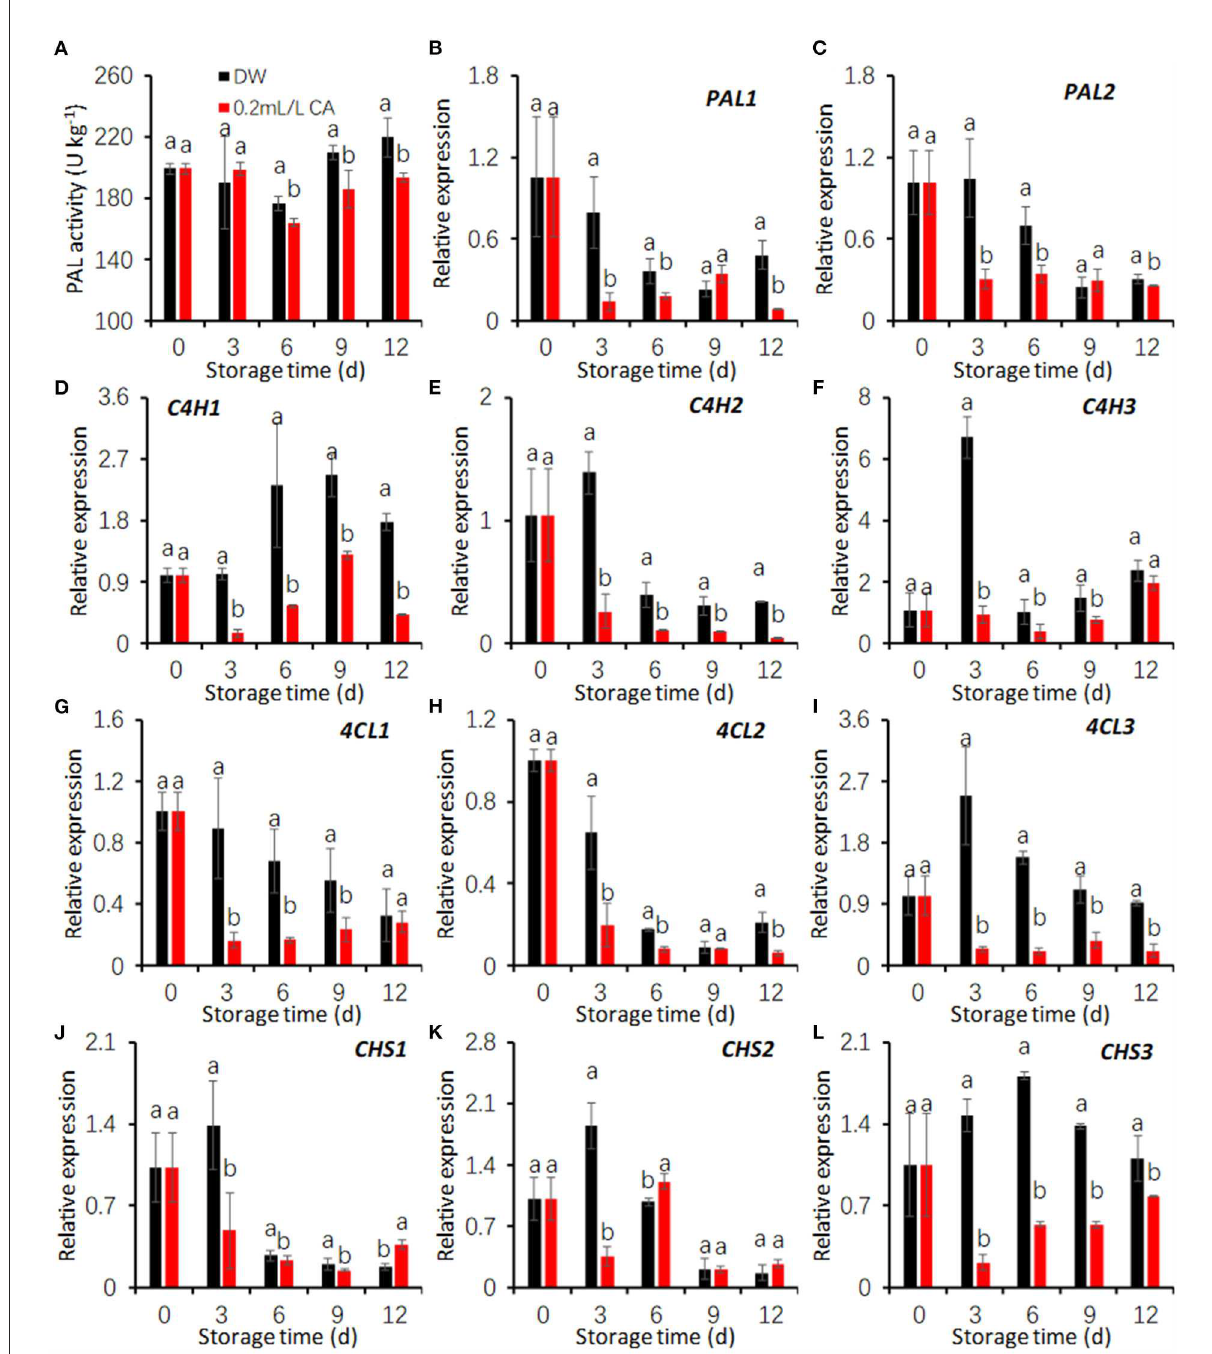
FIGURE4 Effects of 0.2 mL/L citronellal (CA) treatment on the phenolic biosynthesis in fresh-cut taros. (A–C) PAL activity and gene expression; (D–F) relative expression of C4H genes; (G–I) relative expression of 4CL genes; (J–L) relative expression of CHI genes. DW, distilled water. The expression levels were all normalized to 100% (1.0) at 0 d (before treatment). Each value is presented as the mean ± SE ( n = 3). Statistical differences ( p ≤ 0.05) are indicated as different letters above the